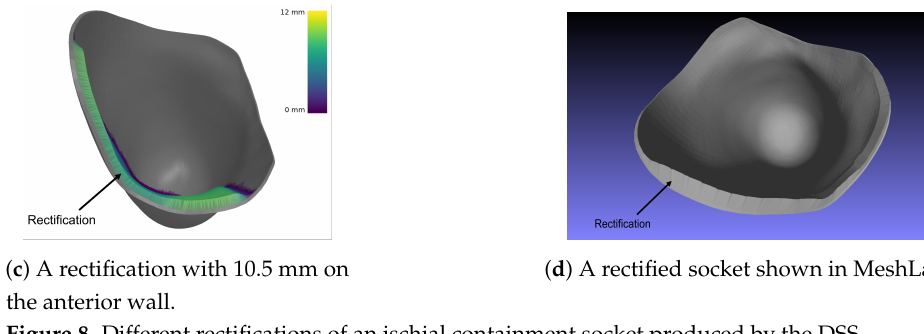
Figure 8. Different rectifications of an ischial containment socket produced by the DSS.